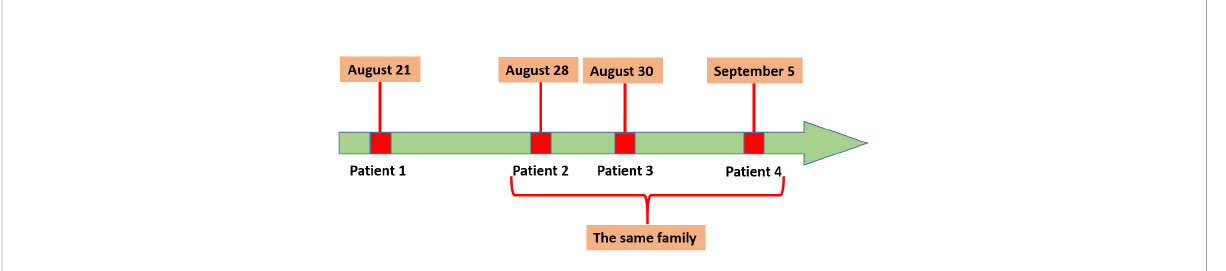
FIGURE 1 Disease onset in the four patients. Patient 1 was the fi rst to develop symptoms on August 21, 2021, and Patients 2, 3, and4 belong to the same